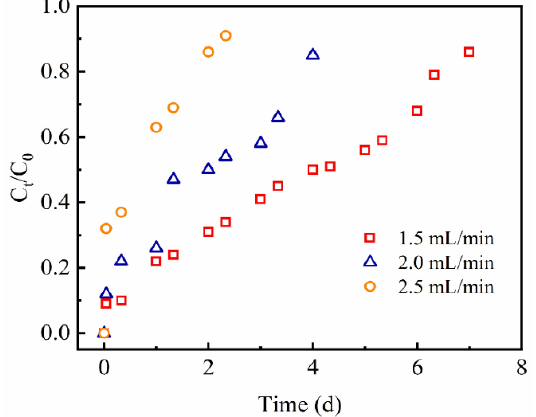
Figure 9. Effect of influent solution concentration on TCS breakthrough curve.